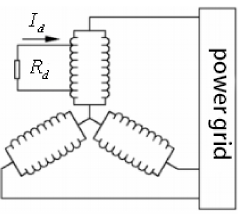
Figure 4. Stator windings short-circuit schematic.